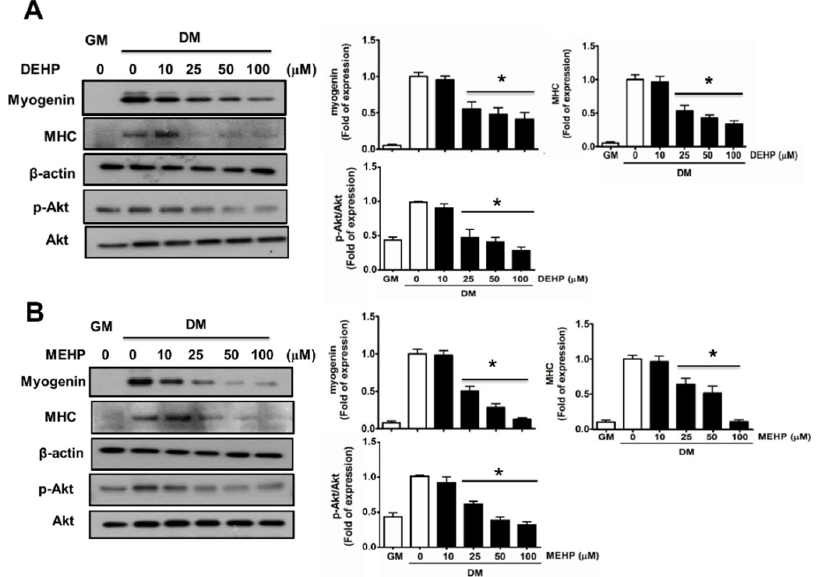
Figure 4. The changes in myogenesis-related protein expression in C2C12 myoblasts treated with both DEHP and MEHP. Under differentiation medium (DM), C2C12 cells treated with DEHP ( A ) or MEHP ( B ) (10–100 μ M) were observed. GM indicated as growth medium. The analysis of protein expression for myogenin, myosin heavy chain (MHC), phospho-Akt, and Akt was performed using Western blot. An internal control using β -actin was performed. The densitometric analysis of proteins via Western blot was performed. Data are presented as means ± SEM (at least three independent experiments, triplicate repeats in each); p < 0.05 indicates significance compared to the control (*).